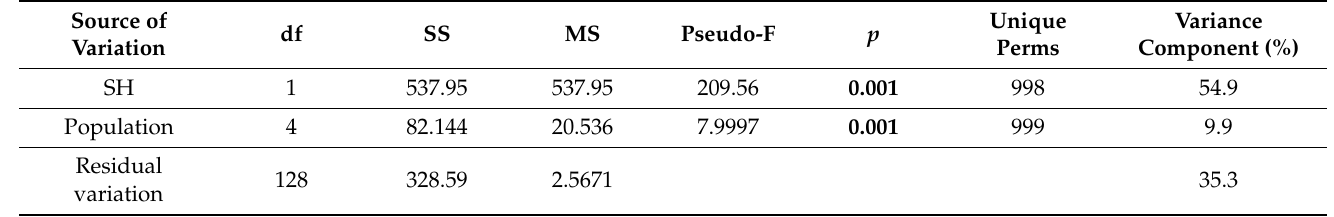
Table 4. Results of PERMANCOVA test with shell height (SH) and population identity (Population)) as covariates. p values are significant levels estimated by permutations of residuals ( p < 0.05 are given in bold).